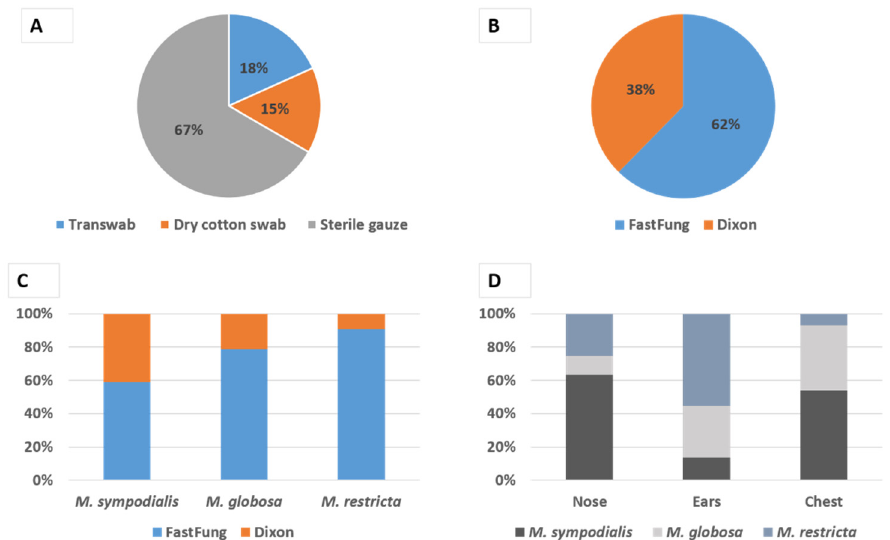
Figure 1. Malassezia species isolation. Relative contribution to Malassezia spp. positive culture of each sampling technique ( A ) and isolation media ( B ). ( C ) Relative contribution (CFU) of the Dixon agar and FastFung medium to the isolation of each detected Malassezia species. ( D ) Relative abundance (CFU) of each detected Malassezia species in the positive culture according to the body site sampled.